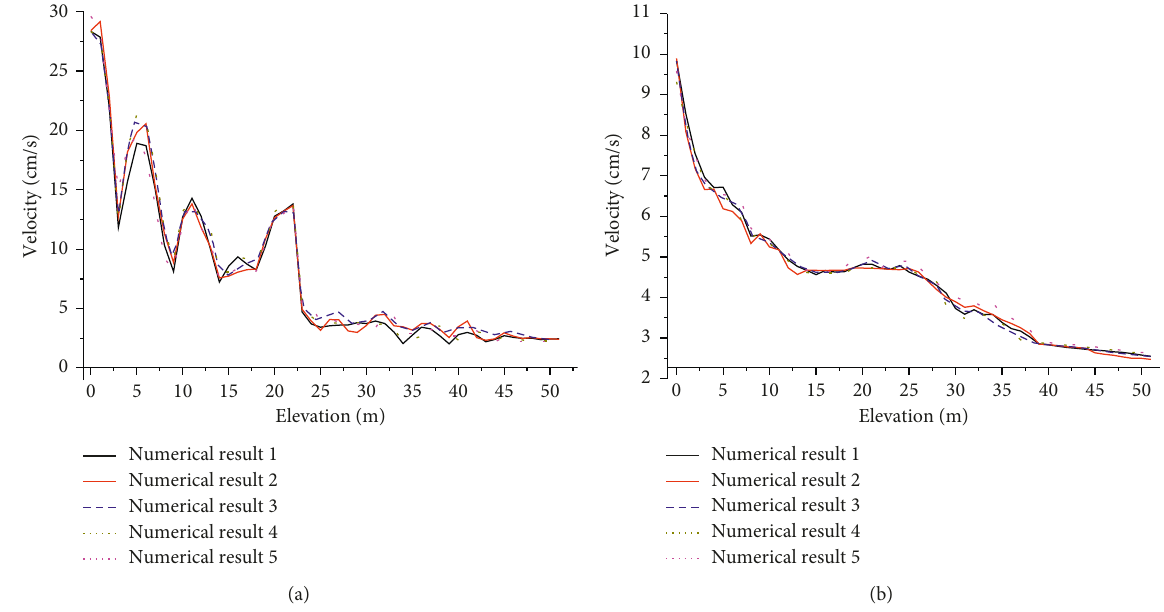
Figure 12: Curves of different geomorphology characteristics of the rock anchor beam in the model. Numerical calculation results of the model of the rock anchor beam (a) after casting and (b) before